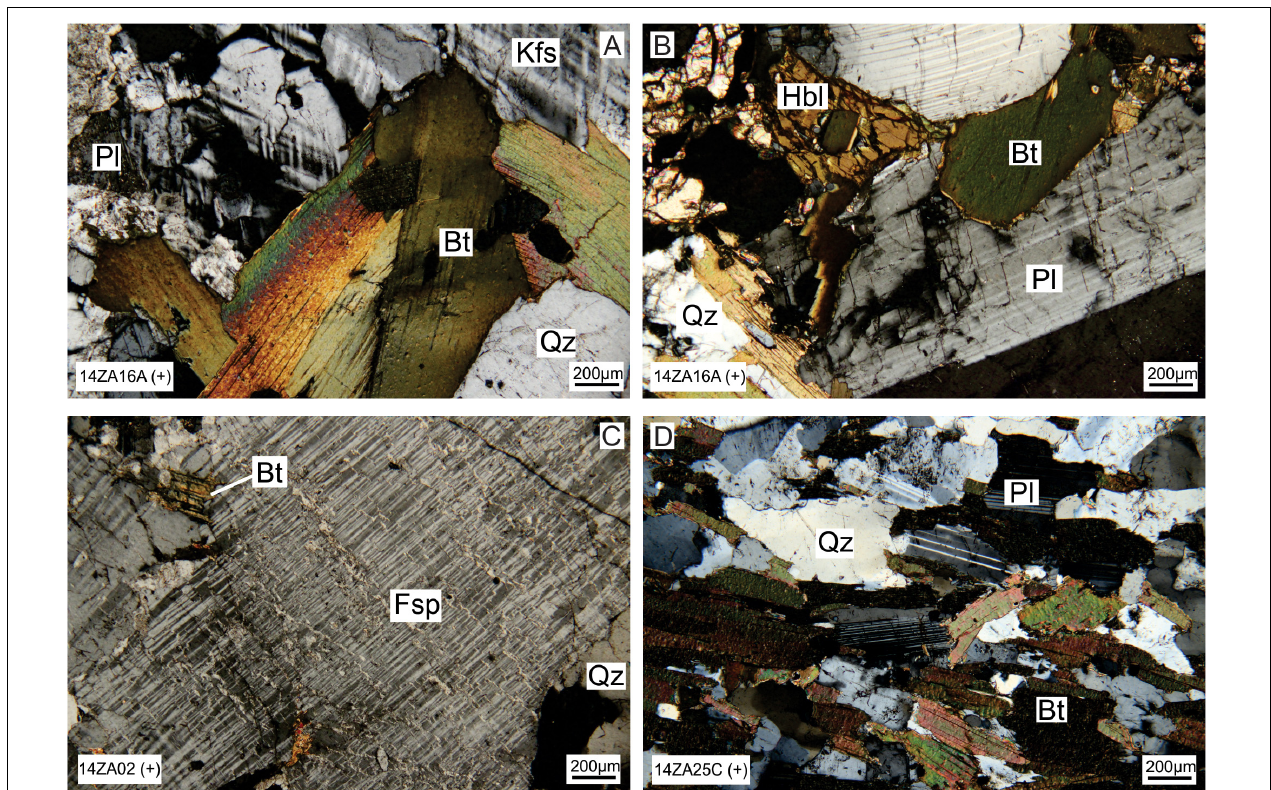
FIGURE 5 | Photomicrographs of the Guéra Massif collisional granites under crossed polarizers. Panels (A,B) are from 14ZA16A of the 590 Ma granites, and (C) 14ZA02, and (D) 14ZA25C of the 595 Ma granites. Qz, quartz; Pl, plagioclase; Bt, biotite; Kfs, potassium feldspar; Fsp, perthitic feldspar, Hbl,